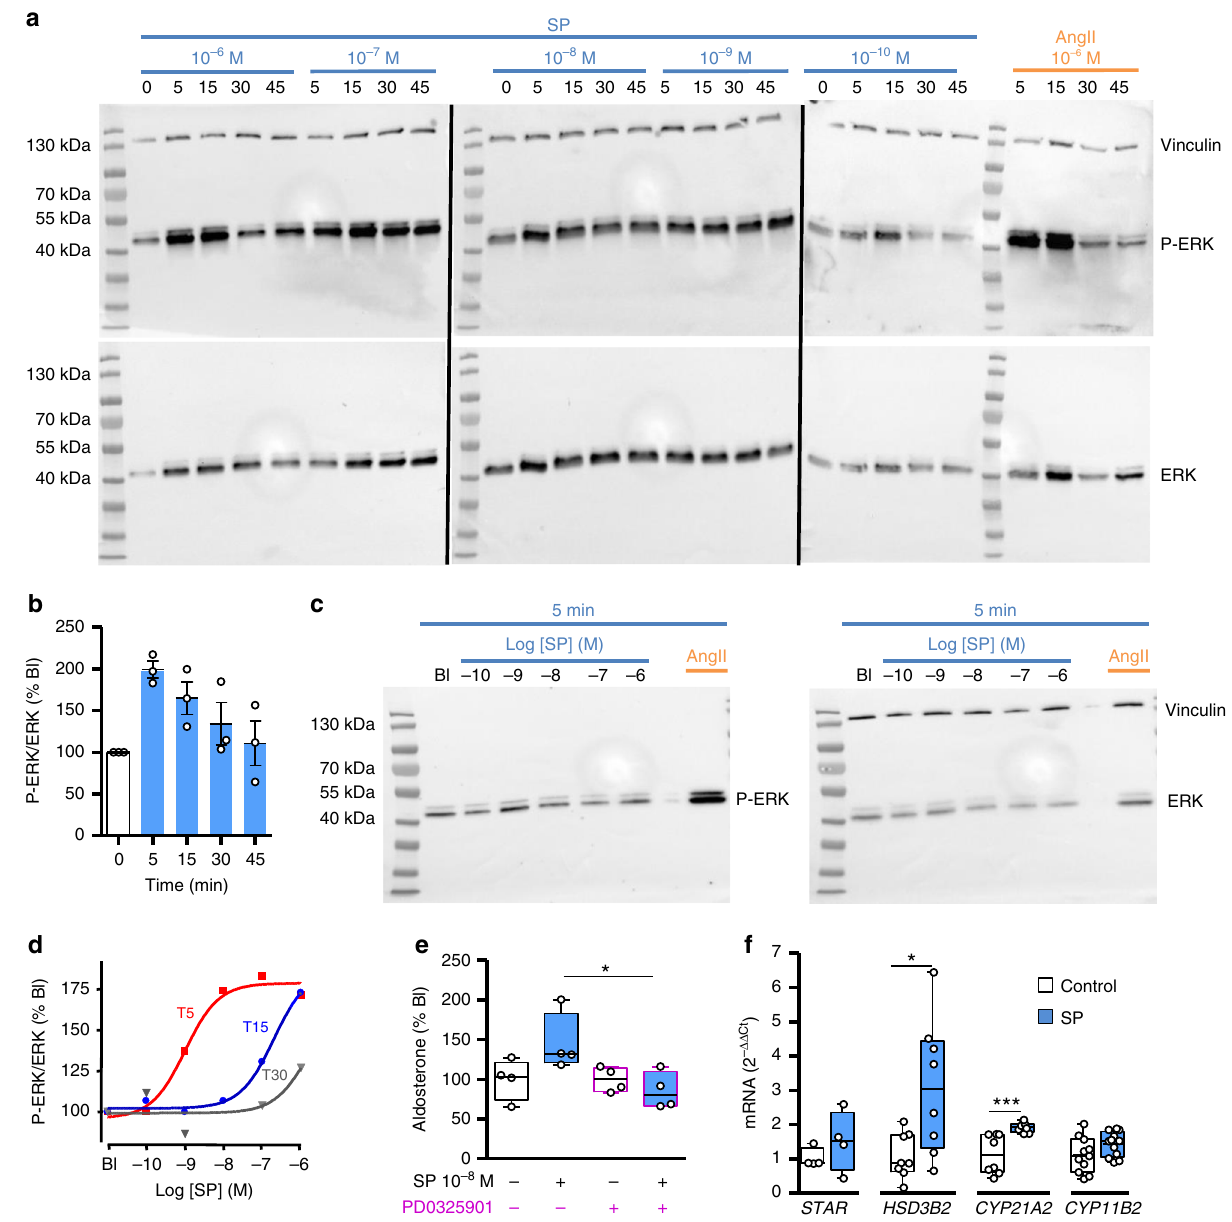
Fig. 5 Coupling of tachykinin receptors to ERK signalling pathway in cultured adrenocortical cells. a Representative western blots showing the kinetics of the phospho-ERK (upper panels) and ERK (lower panel) levels in response to SP (from 10 − 6 to 10 − 10 M) and Ang II (10 − 6 M) after incubation of cultured cells for 5, 15, 30 and 45min (three blots processed in parallel showing samples derived from the same culture experiment). Immunolabellings for phospho- ERK and ERK were successively performed on the same membranes. Ang II and vinculin were used as positive and loading controls, respectively. b